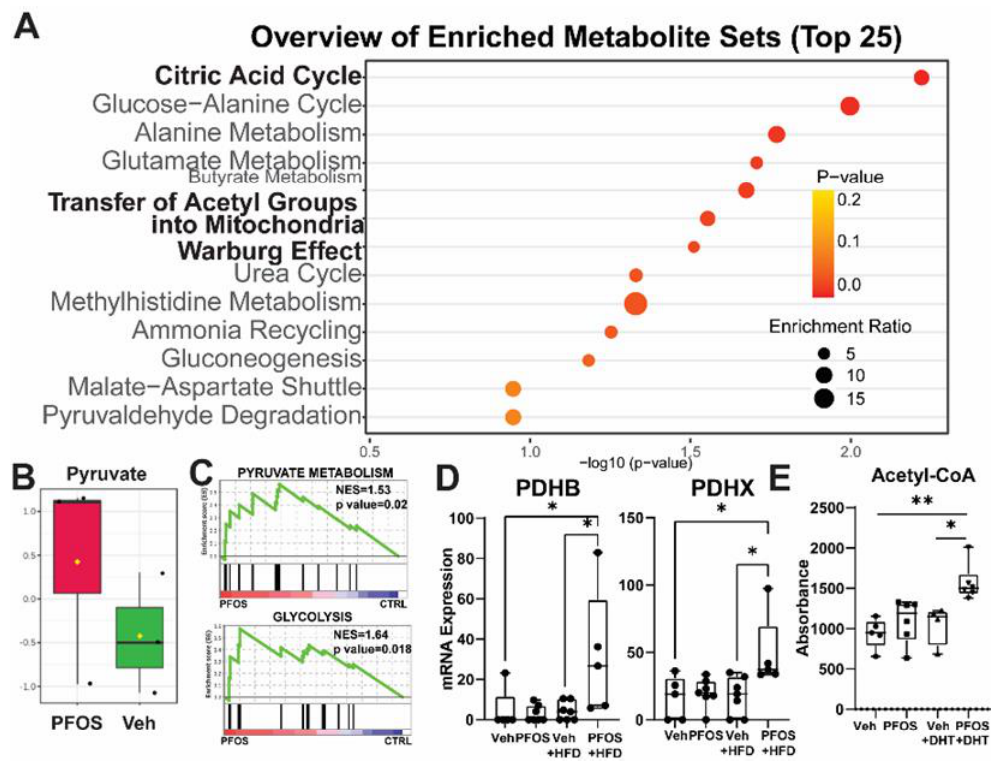
Figure 3. PFAS treatment increases pyruvate and acetyl-CoA levels in RWPE-kRAS cells. ( A ). PFOS-induced metabolites in RWPE-kRAS cells identified by GC/MS analysis. ( B ). Pyruvate levels from ( A ). ( C ). GSEA of PFOS + HFD-induced genes in RWPE-kRAS xenografts identified by RNA-seq. ( D ). mRNA expression of PDHB and PDHX, components of PDC, were increased with PFOS and a high-fat diet (HFD) in RWPE-kRAS xenografts. ( E ). Acetyl-CoA levels in PFOS-treated RWPE-kRAS cells (10 nM PFOS ± DHT, 24 h) using a fluorescence-based assay. * p < 0.05, ** p < 0.01.